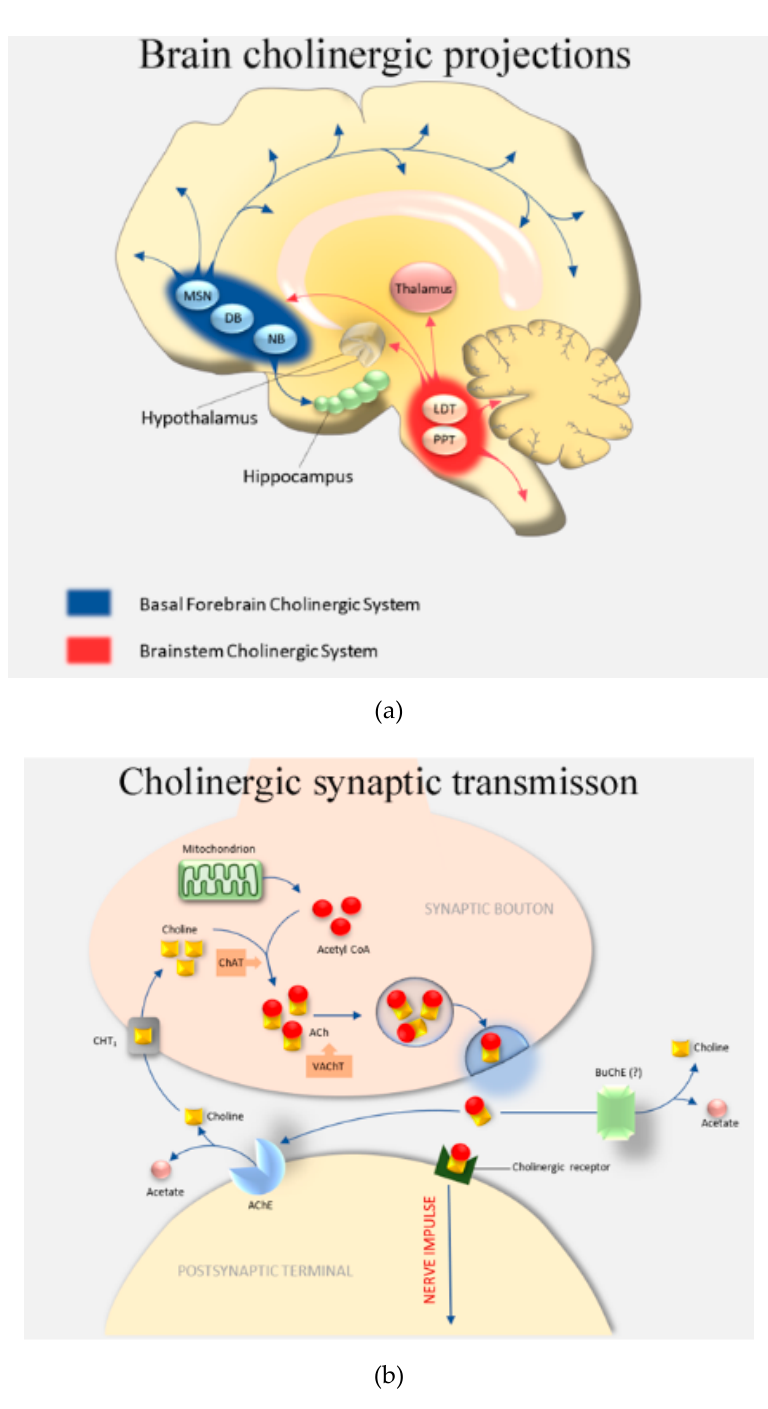
Figure 1. The cholinergic system and cholinergic synapse. ( a ) Overview of the cholinergic system: DB, diagonal band of Broca; LDT, laterodorsal pontine tegmentum; MSN, medial septal nucleus; NB, nucleus basalis; PPT, pedunculopontine tegmental nucleus. ( b ) The cholinergic synapse: ACh, acetylcholine; AChE, acetylcholinesterase; BuChE, butyrylcholinesterase; ChAT, choline acetyltransferase; CHT 1 , choline transporter; VAChT, vesicular acetylcholine transporter.